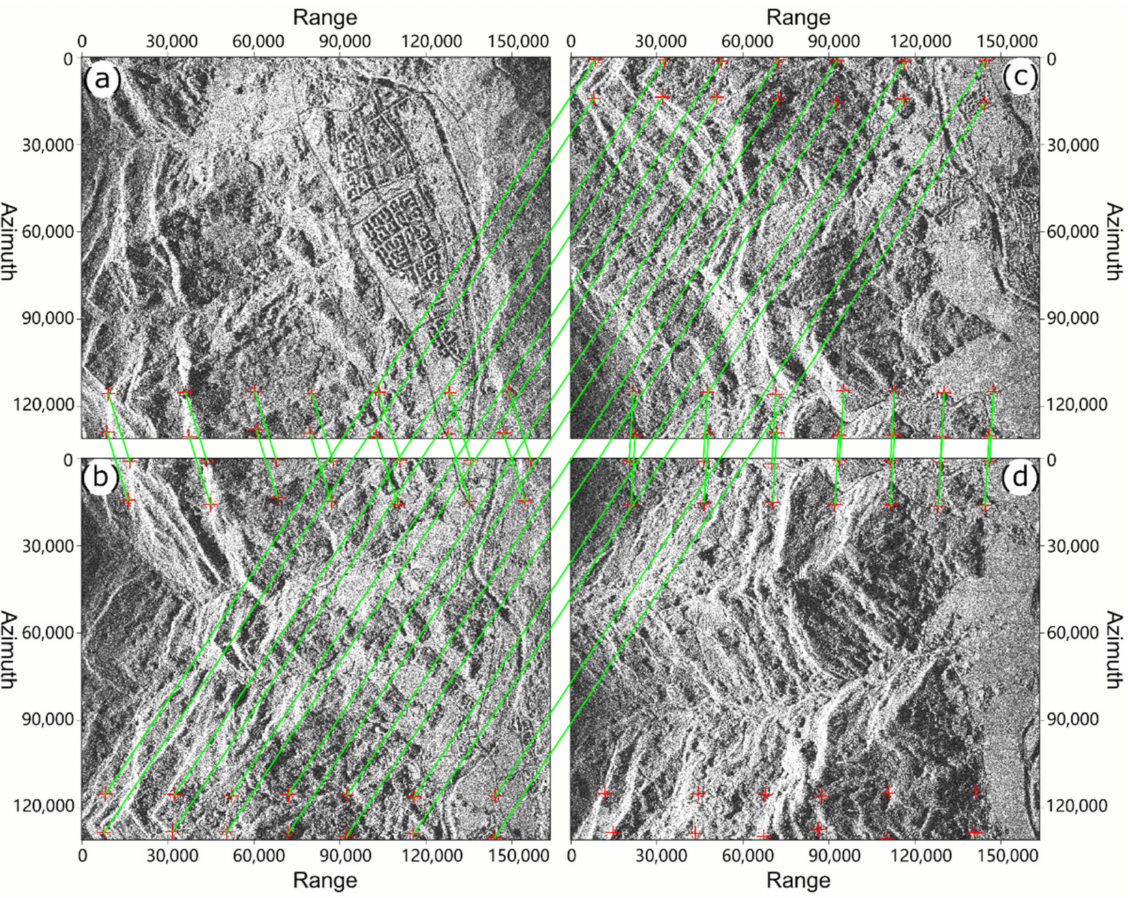
Figure 10. TPs (red crosses) and their connections (green lines) in the first 4 scenes of the Qionglai experiment, where ( a – d ) refer to the magnitude maps of the 4 scenes.